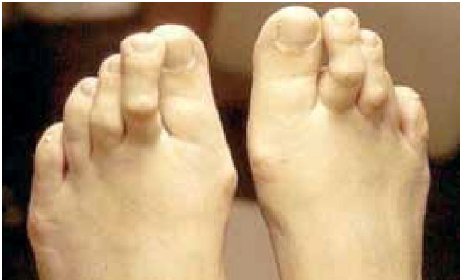
Figure 6. Clawing of toes